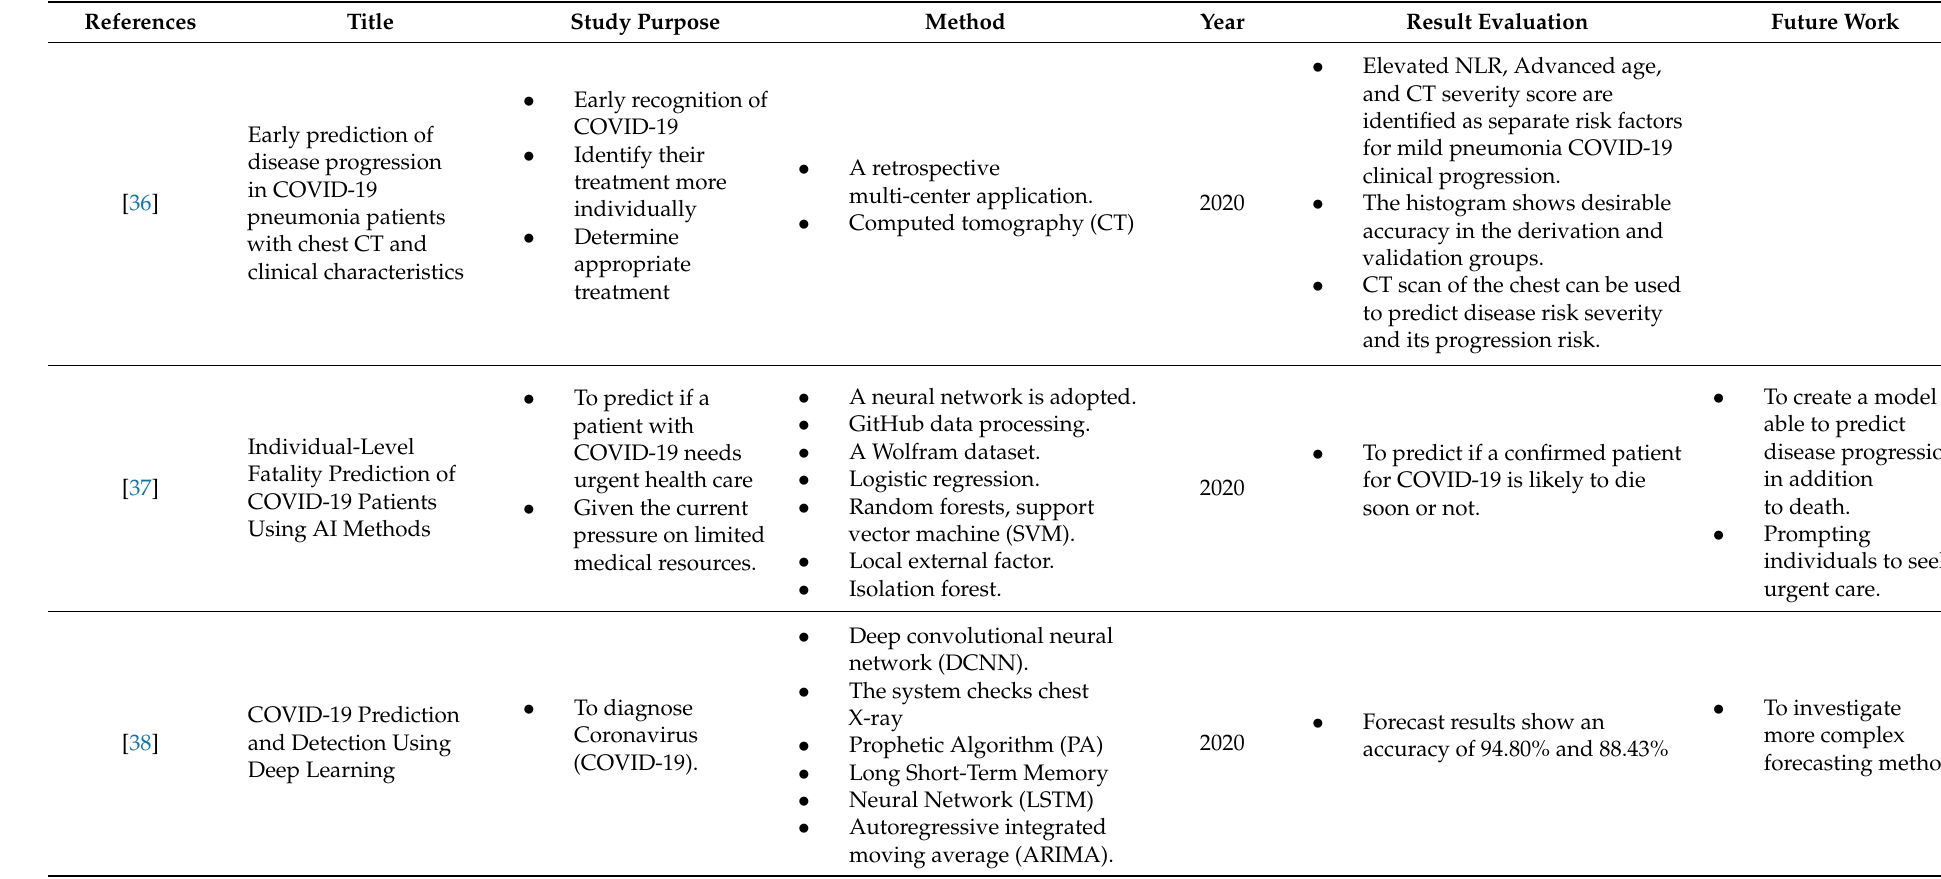
Table 1. Some Studies of AI Methods for Body Language Elements to Identify the